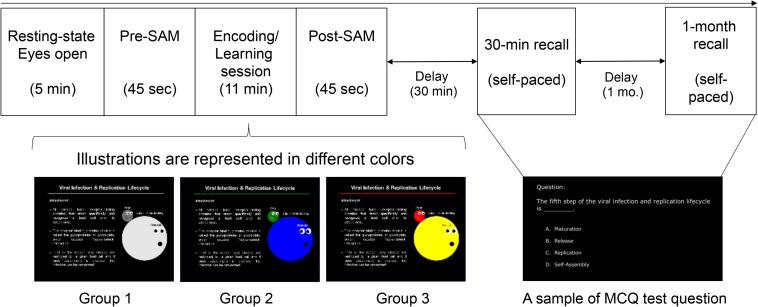
Experimental protocol and stimuli. The sequence of task sessions (top), the three versions of MLMs for the learning task (bottom) [achromatic-colored illustrations (Group 1: GB&W); cool-colored illustrations (Group 2: CCI); and warm-colored illustrations (Group 3: WCI)], and a sample of test questions for the memory recall tests.